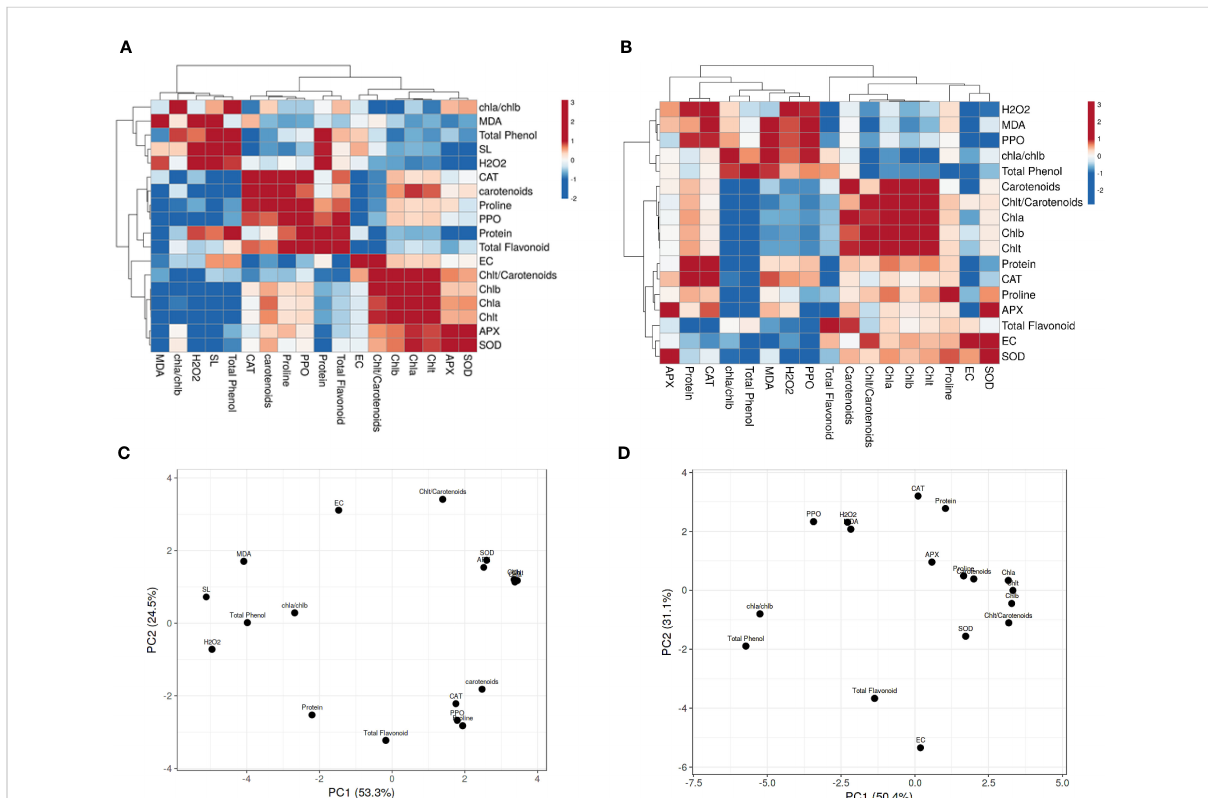
FIGURE 5 Heatmap and PCA analysis of Pearson ’ s correlation for the targeted parameters in 90 days ’ plants in both SP (A, C) and SP+F (B, D) conditions. Pink and blue color represents positive and negative correlations,